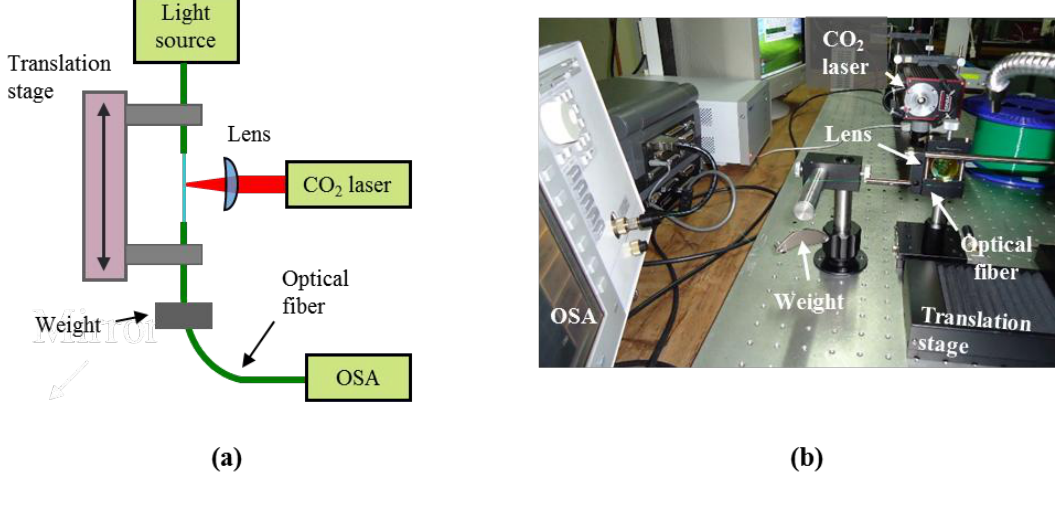
Figure 5. ( a ) Schematic and ( b ) photograph of the setup used for CO LPFG on a Corning SMF-28 fiber.